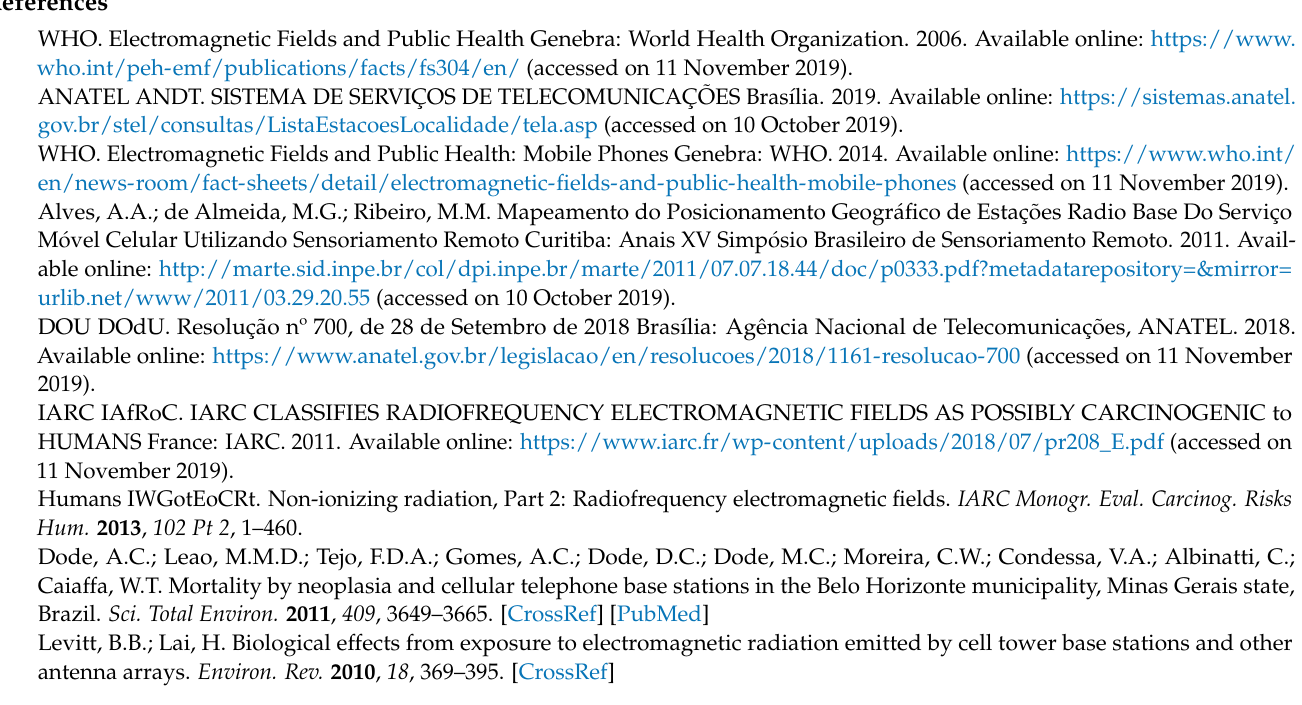
Table S2: Adjusted risk of brain cancer mortality in Brazilian